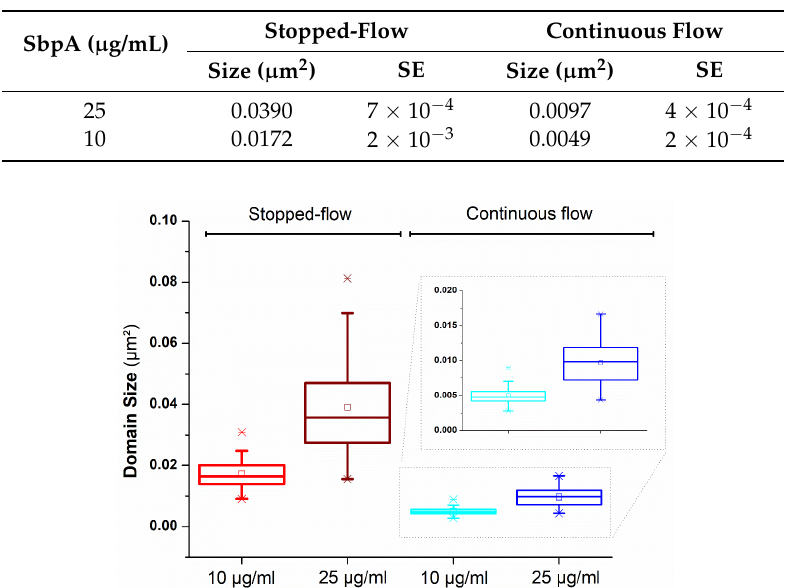
Figure 4. Boxplot showing the SbpA S-layer domain dimension values after an incubation of 30 min. The number of domains considered for the statistical analysis was N = 50. The square (□) in the box plot represents the mean value, the box-splitting horizontal line gives the median, and the upper and lower value are indicative of the achievement of either the 99% or 1% of the population, respectively. Crosses indicate the highest and lowest values measured. The inset on the right magnifies the boxplots from experiments in dynamic flow mode.